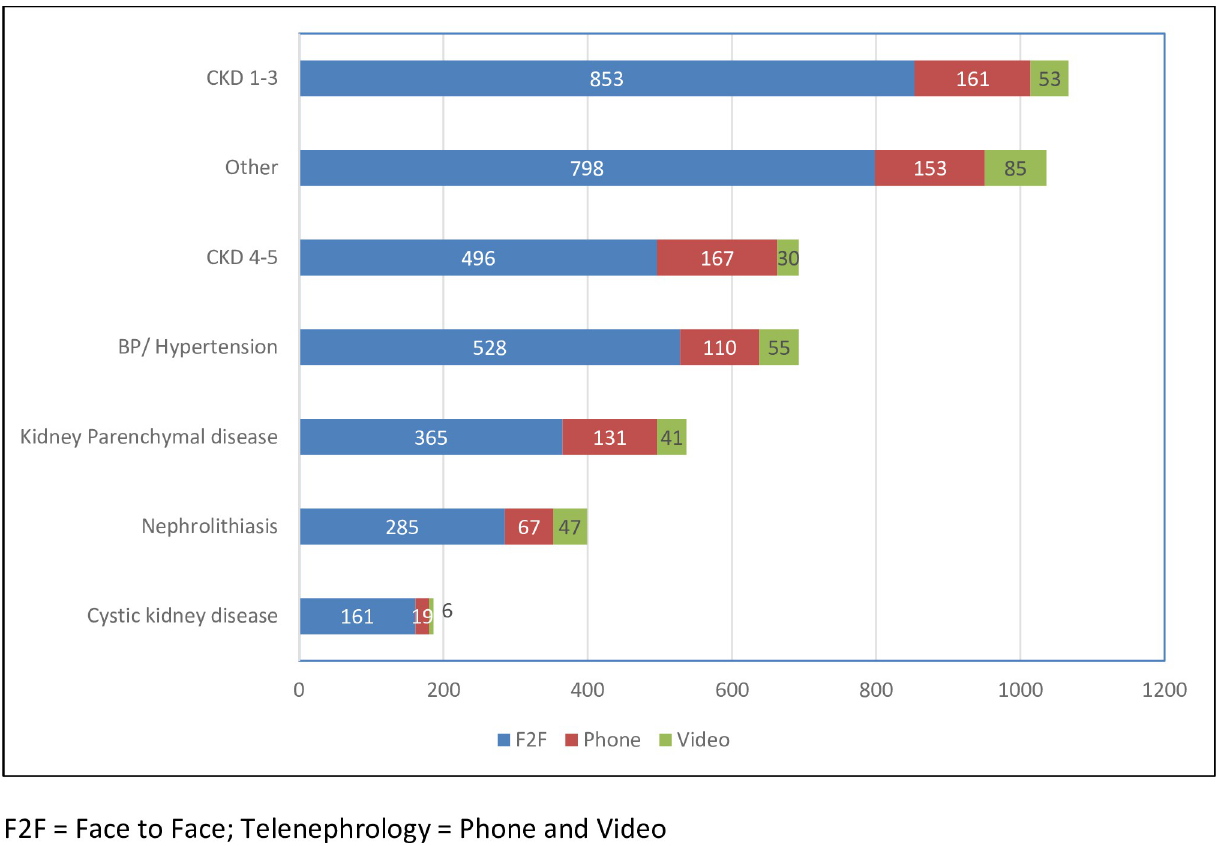
Fig 4. Patient distribution by visit type and diagnoses groups (all patients, face to face and telenephrology). The majority of patients in the study were best characterized as CKD, however, the entire spectrum of clinical visits was supported by telenephrology.